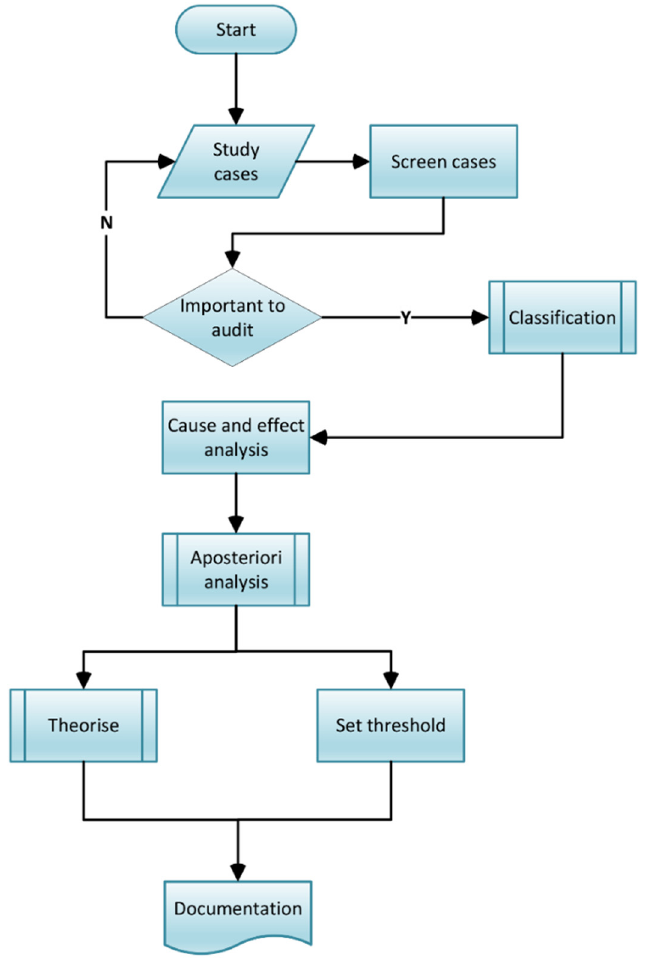
Figure 2. Research methodology block